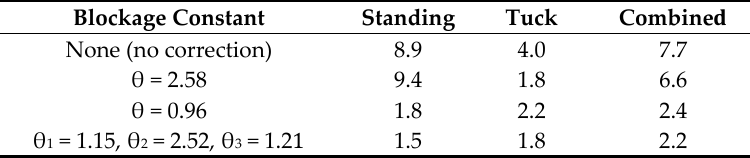
Table 2. Mean percentage absolute error (MAE) in C D measured for the Standing and Tuck positions at the NTNU and PoliMi wind tunnels, with and without Maskell’s blockage correction. The mean standard error in measurements was 0.005 (0.5%). θ 1 , θ 2 and θ 3 indicate the optimized blockage constants for standing, tuck and both positions combined,